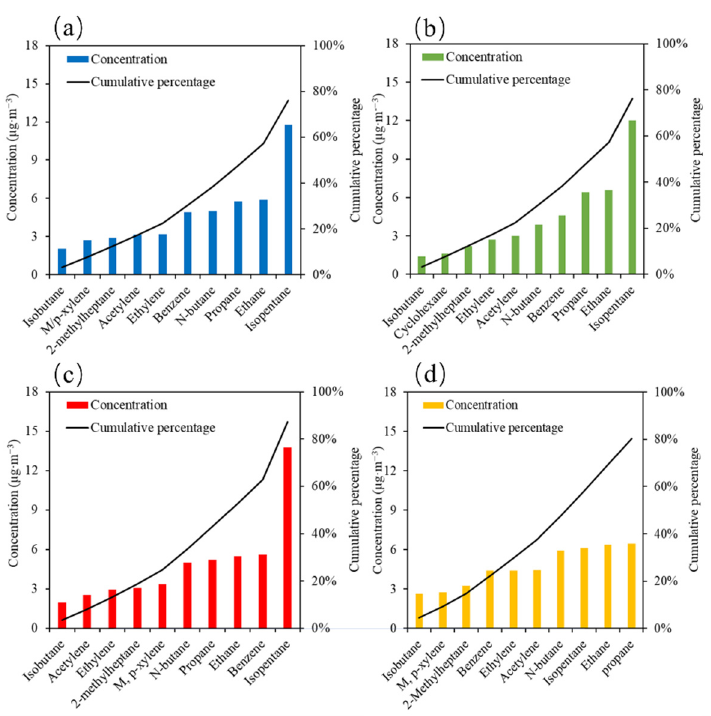
Figure 2. Top 10 VOC concentrations during ( a ) total sampling time, ( b ) spring, ( c ) summer and ( d ) winter.